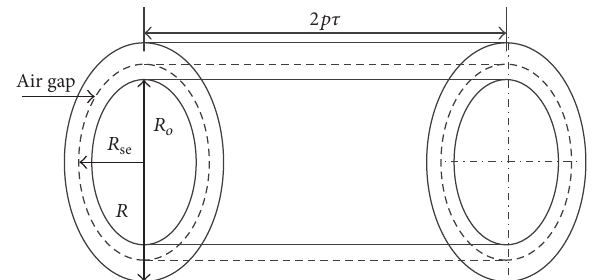
Figure 4: The schematic diagram of computational volume in the air